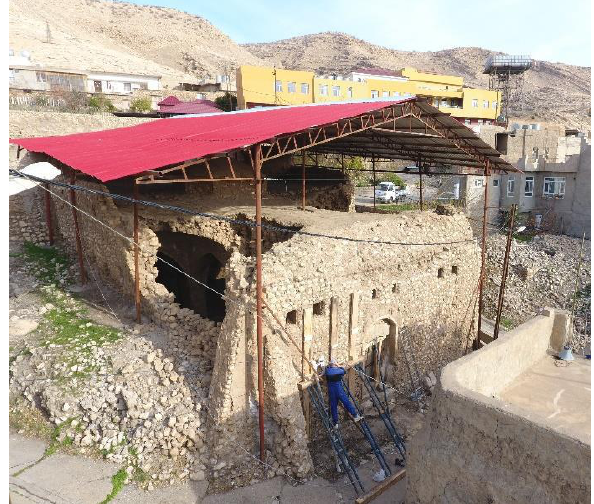
Figure 7 a, b. Dalal Bridge in Zakho (virtual model and vector model)